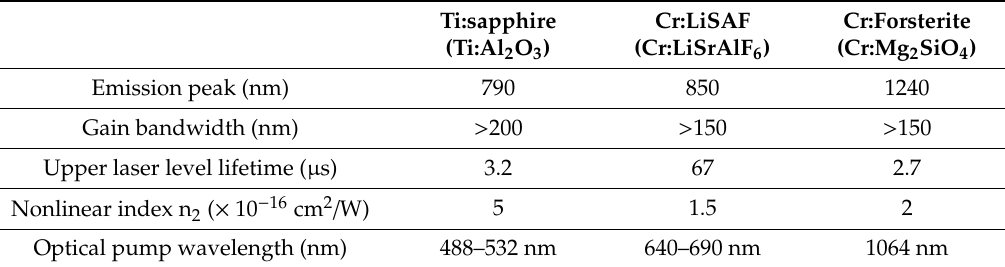
Table 1. Spectroscopic properties of laser